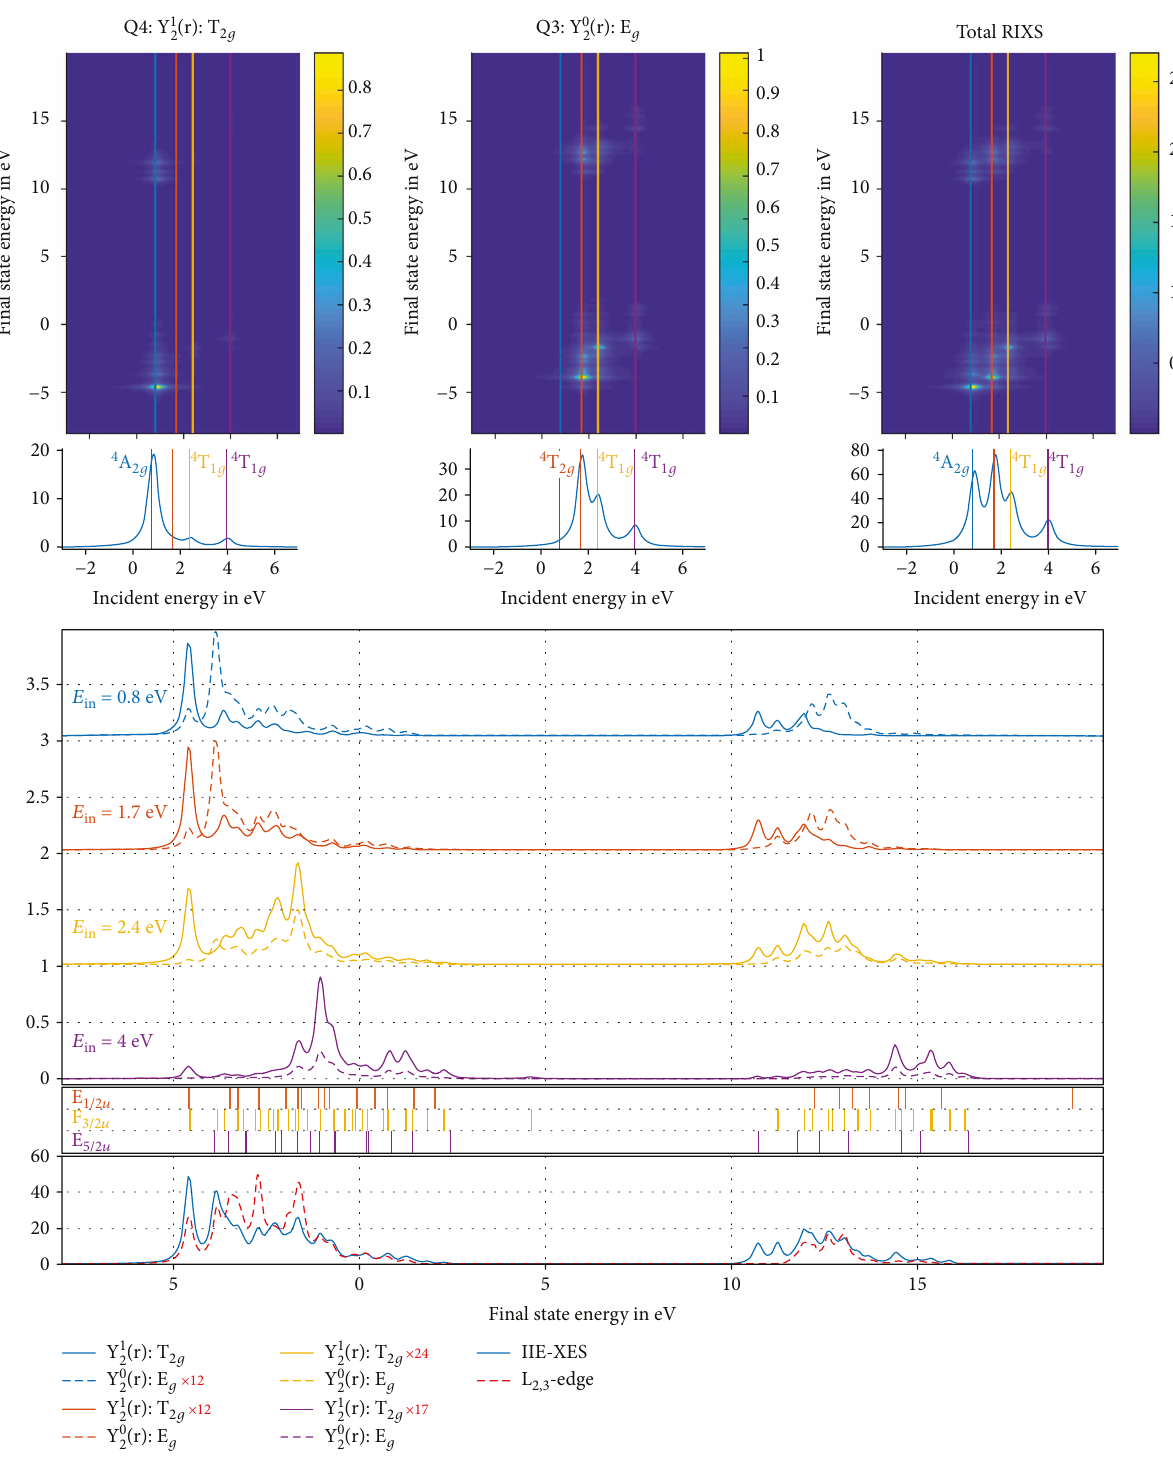
Figure 54: Calculated 1s2p RIXS spectrum for Co 2+ ( 3d 7 ) for 10D q = 0 9 eV (high